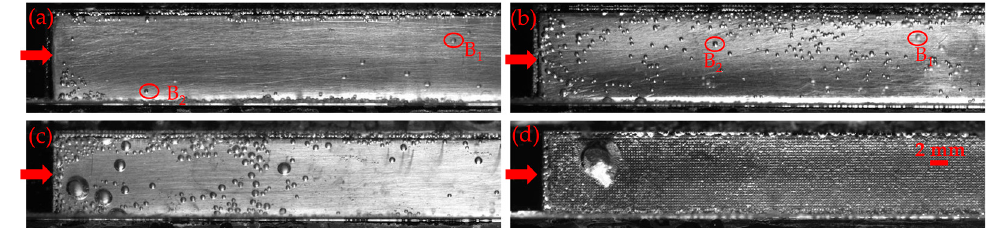
Figure 8. Bubble attachment on different surfaces downstream of the backward-facing step when the time is 88 s. ( a ) Super hydrophilic surface; ( b ) hydrophilic surface; ( c ) hydrophobic surface; ( d ) superhydrophobic surface.